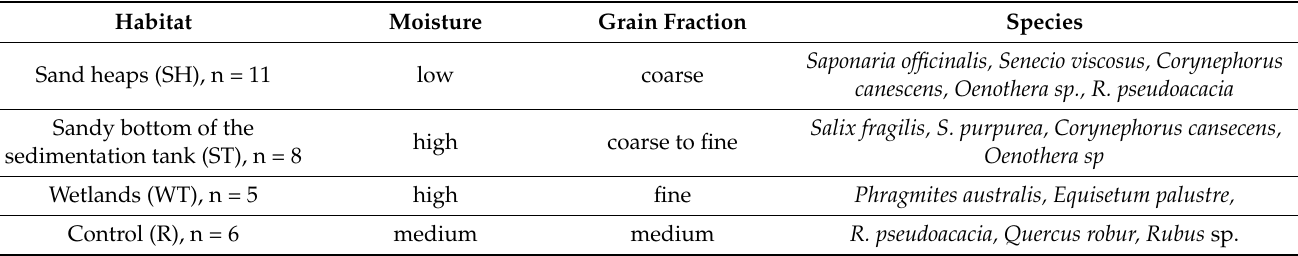
Table 2. The characteristics of the study